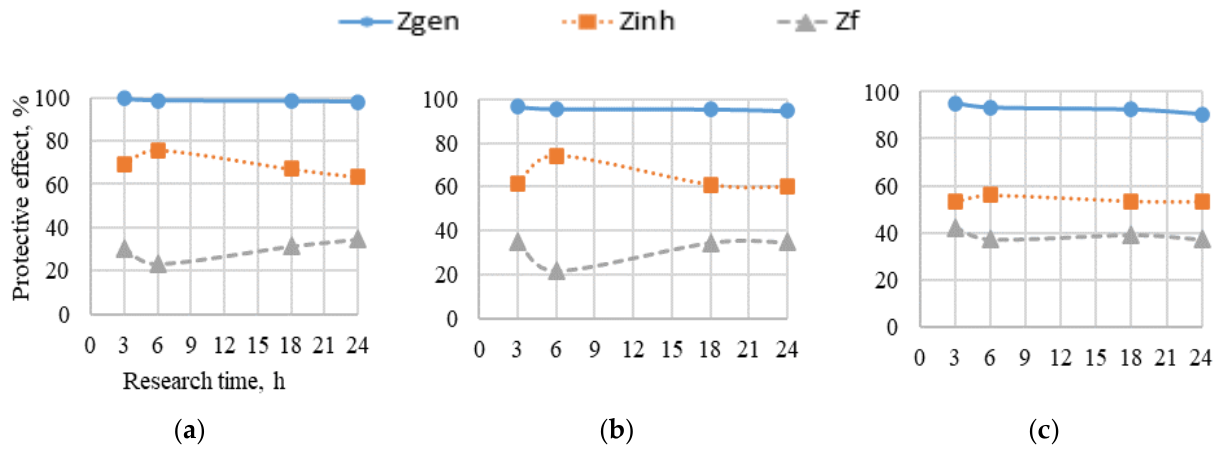
Figure 7. The protective effect of the IC-1 inhibitor at conc. 0.5% wt. in hydrochloric acid 5% wt. ( a ), 10% wt. ( b ), and 15% wt. ( c ).